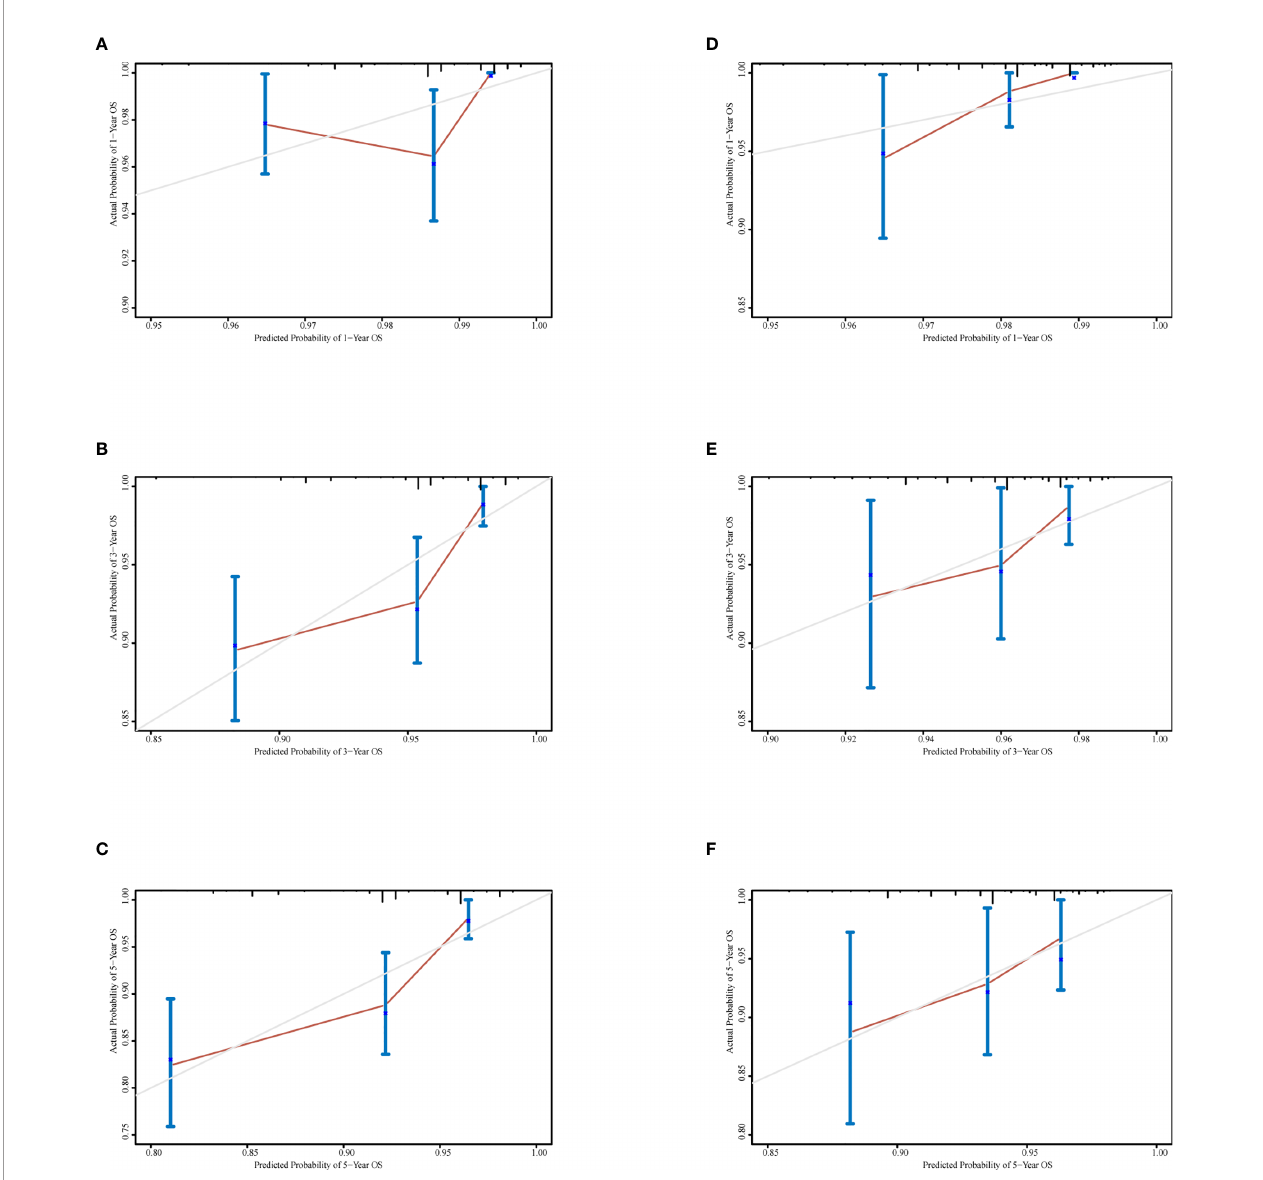
FIGURE 3 | Calibration curves to predict 1-, 3-, and 5-year overall survival in the training set and the validation set. (A – C) Calibration curves for 1-, 3-, and 5-year overall survival in the training set. (D – F) Calibration curves for 1-, 3-, and 5-year overall survival in the validation